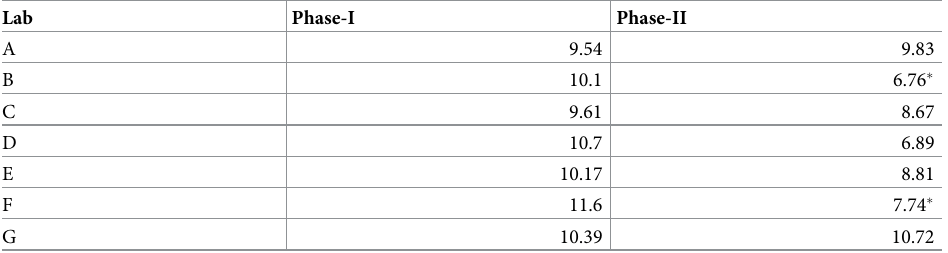
Assessment for copy number changes was limited to genes present on the OFA assay. The asterick denotes samples where the MAPD value was >